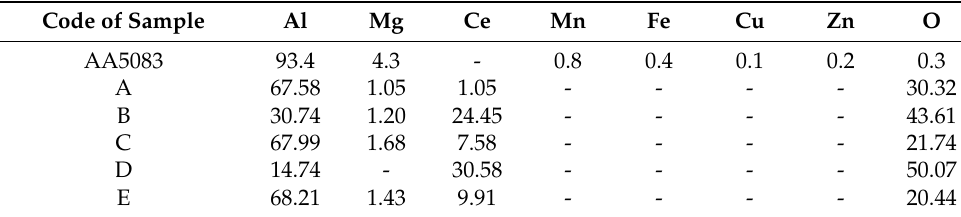
Table 4. Percentage of the element of EDS analysis of different cerium coated and uncoated